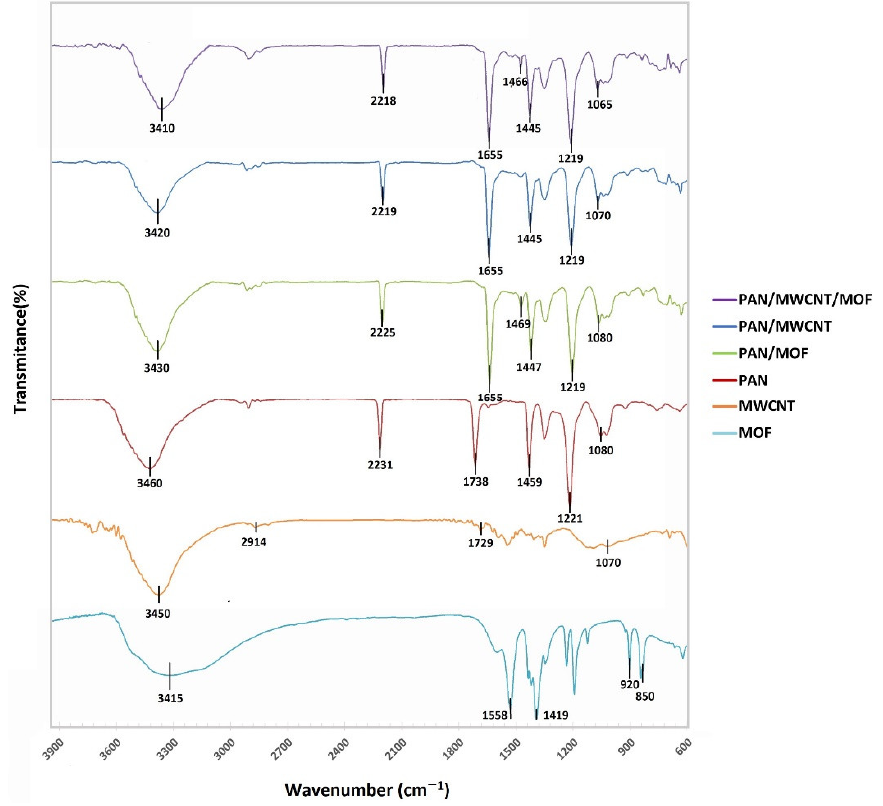
Figure 13. FTIR spectra of Ni-MOF-74 powder, PAN/MWCNT, PAN/MOF, and PAN/MWCNT/MOF nanofibers.